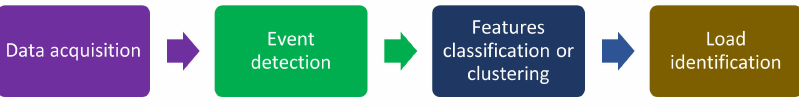
Figure 2. Steps of the NILM